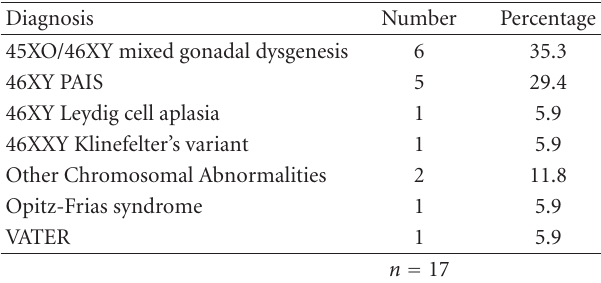
Table 1: Distribution of specific DSD